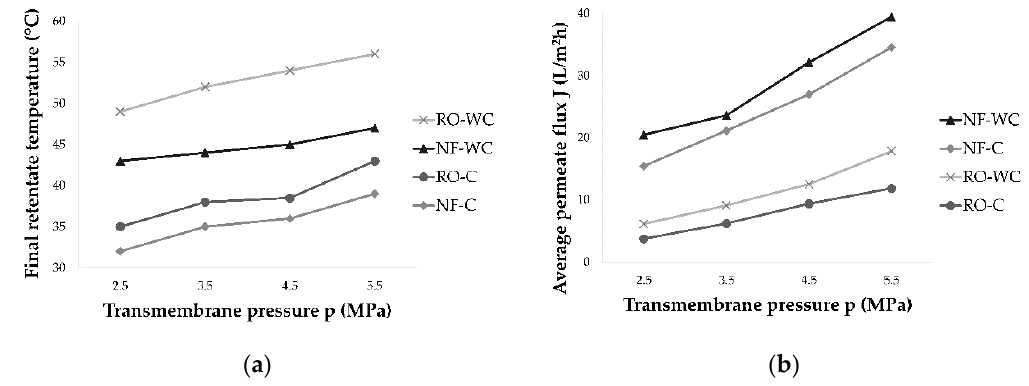
Figure 2. Influence of transmembrane pressure (2.5, 3.5, 4.5 and 5.5 MPa) on: ( a ) final retentate temperature (°C) and ( b ) average permeate flux (L/m 2 h) during reverse osmosis (RO) and nanofiltration (NF) of Cabernet Sauvignon red wine with (C) and without cooling (WC).